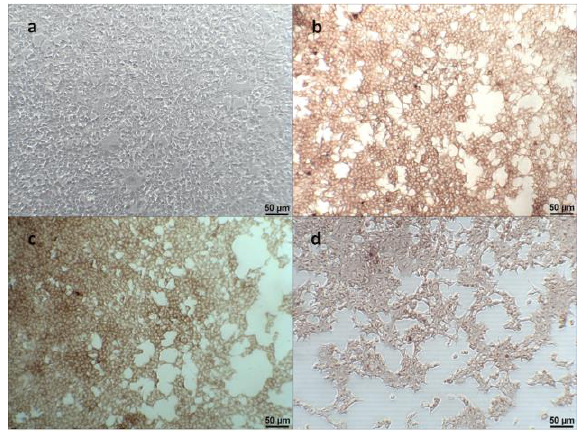
Figure 2. ( a ) Detection of the expression of CC chemokines by immunocytochemistry (ICC) in the naïve parental HEK-293 cells, ( b ) HEK-293 cell lines stably expressing porcine CCL27, ( c ) CCL28, and ( d ) CCL25. The anti-V5 antibodies (1:1000 dilution) was used as the primary antibody, and the polyclonal anti-rabbit/mouse immunoglobulins conjugated with horseradish peroxidase (HRP) was used as the secondary antibody. The coloration was detected using the EnVision-DAB+ system (Dako, Santa Clara, CA, USA). Positive brown signals were identified under an inverted light microscope (Nikon, Tokyo, Japan).